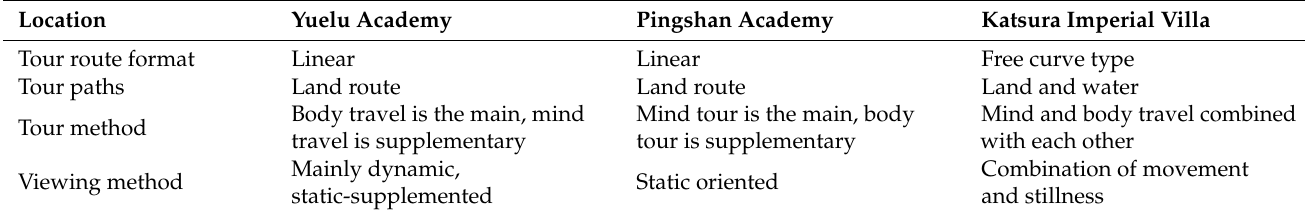
Table 3. Analysis of the tour